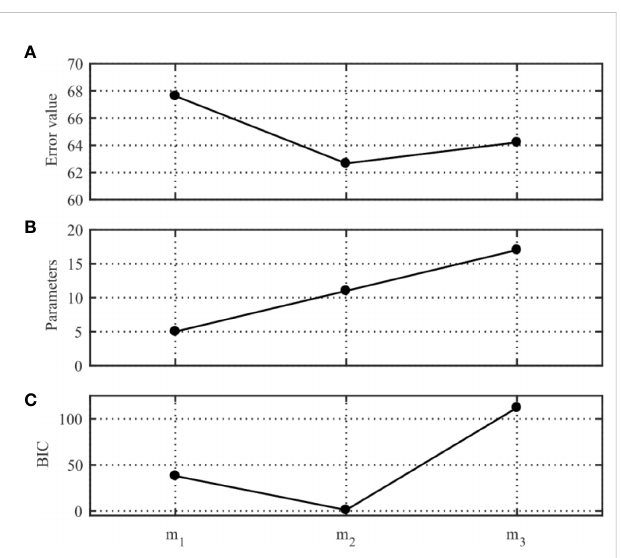
FIGURE 4 Results of the model selection study in terms of the (A) error value, (B) parameters, and (C) BIC, where m 1 , m 2 , and m 3 represent the inversion model of the one-, two-, and three-layer uniformly distributed seabed,